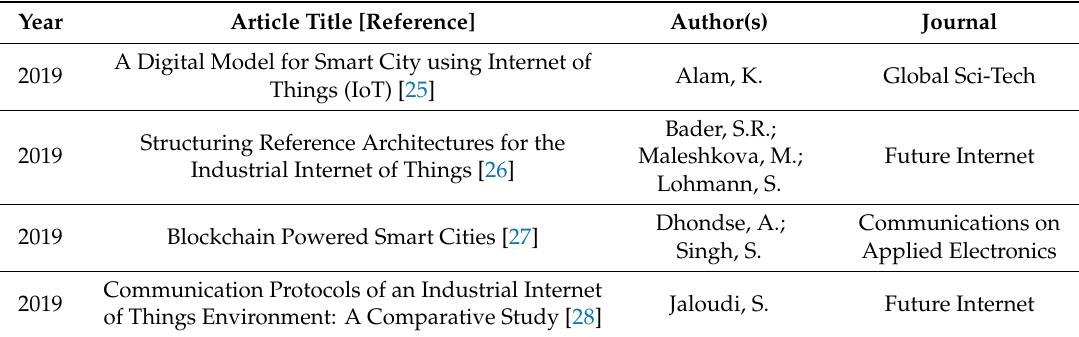
Table 1. Key documents to define the